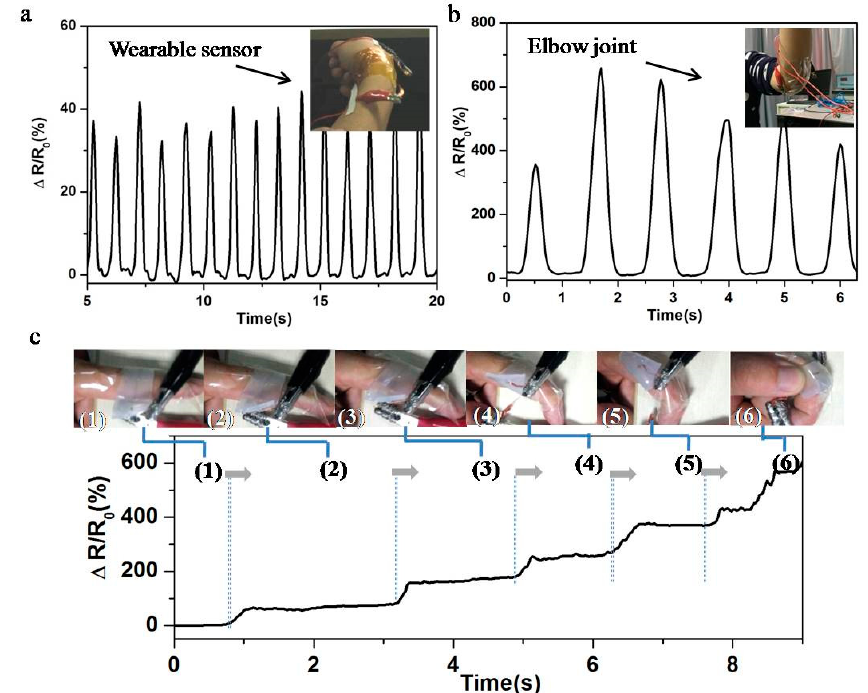
Figure 4. ( a ) The relative resistance change for monitoring of the wrist bending movement at input voltage of 4 V. Inset: the photograph of wearable sensor on the wrist joint. ( b ) The relative resistance change for monitoring of the elbow joint movement at input voltage of 4 V. Inset: the photograph of sensor on the elbow joint. ( c ) The relative resistance change of sensor monitoring the finger bending with different directions at input voltage of 4 V.